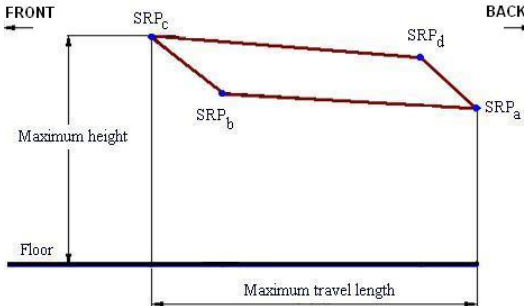
Figure 7. Seat travel path; seat reference point